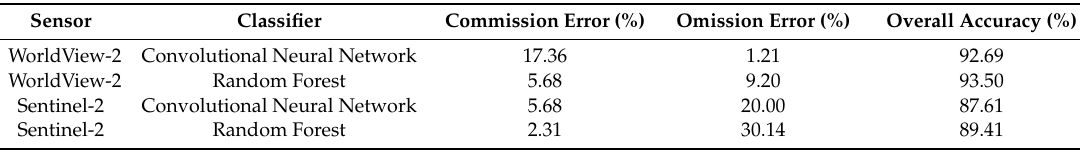
Table 3. Study Site 1 results displaying the commission and omission errors of the shoals class and the overall accuracy for the three shoals, deep water, and land classes.